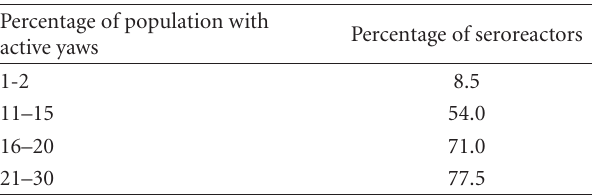
Table 2: Estimating seroreactor prevalence from population preva- lence